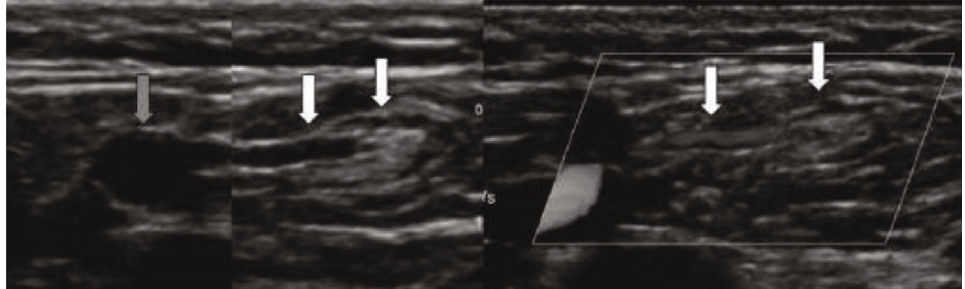
Figure 5: Lymph node vessel draining a lymph node.